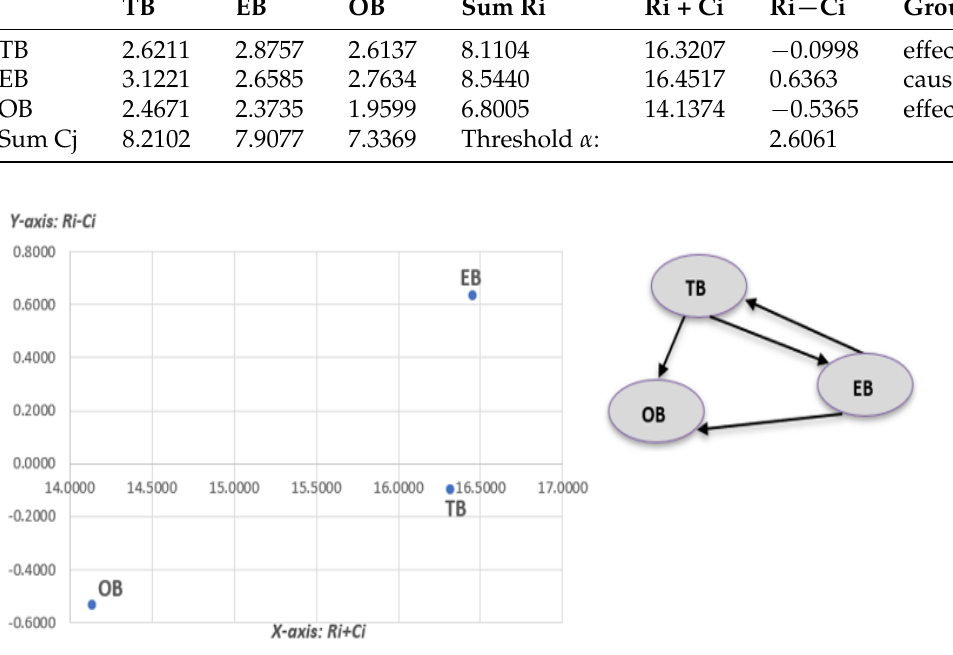
Figure 4. The causal digraph and relationship diagram (main barriers).